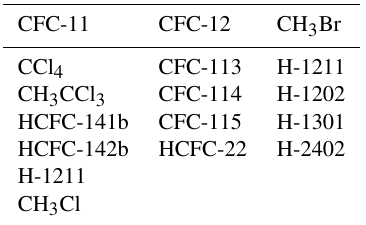
Table 2. List of halocarbons (not explicitly treated in the model) contributing to the lower boundary conditions of CFC-11, CFC- 12 and CH 3 Br. Note that H-1211 contributes to both CFC-11 and CH 3 Br as it contains both Cl and Br. Contributions are included by moles of Cl or